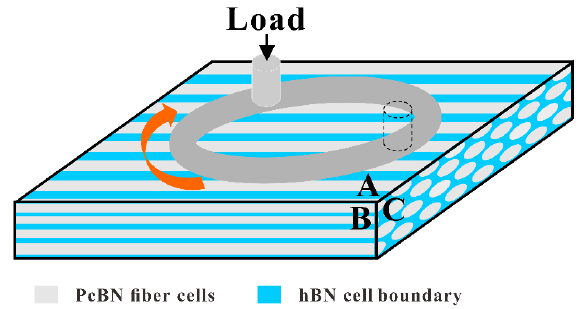
Fig. 1 Schematic diagram of the PcBN/hBN fibrous monolithic ceramics showing different structures, as well as tribological tests on Surface A with a pin-on-disk